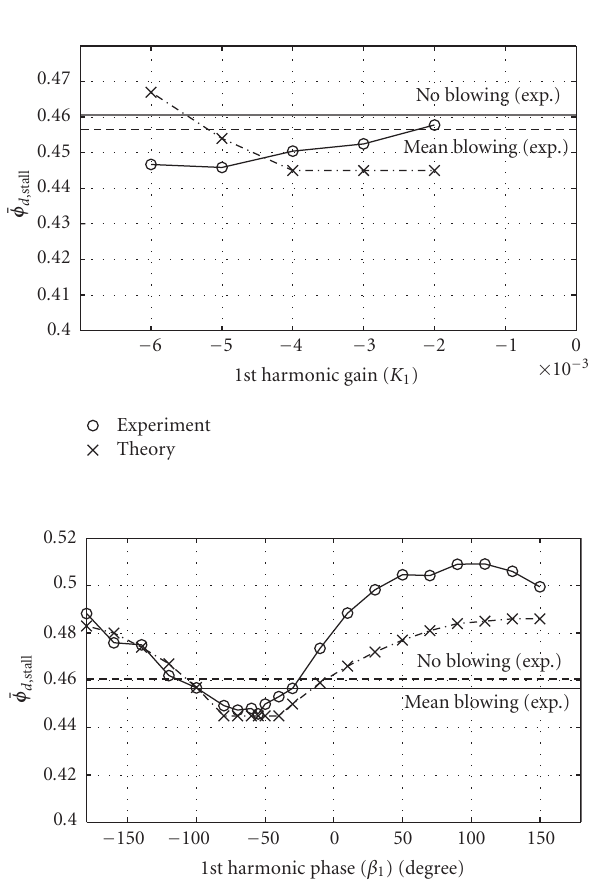
Figure 15: Experimental gain and phase optimization for first har- monic control. Top: gains = [K 1 ,0,0] and phases = [ − 55 ◦ ,0 ◦ ,0 ◦ ]. Bottom: gains = [ − 0 . 005,0,0] and phases = [ β 1 ,0 ◦ ,0 ◦ ].